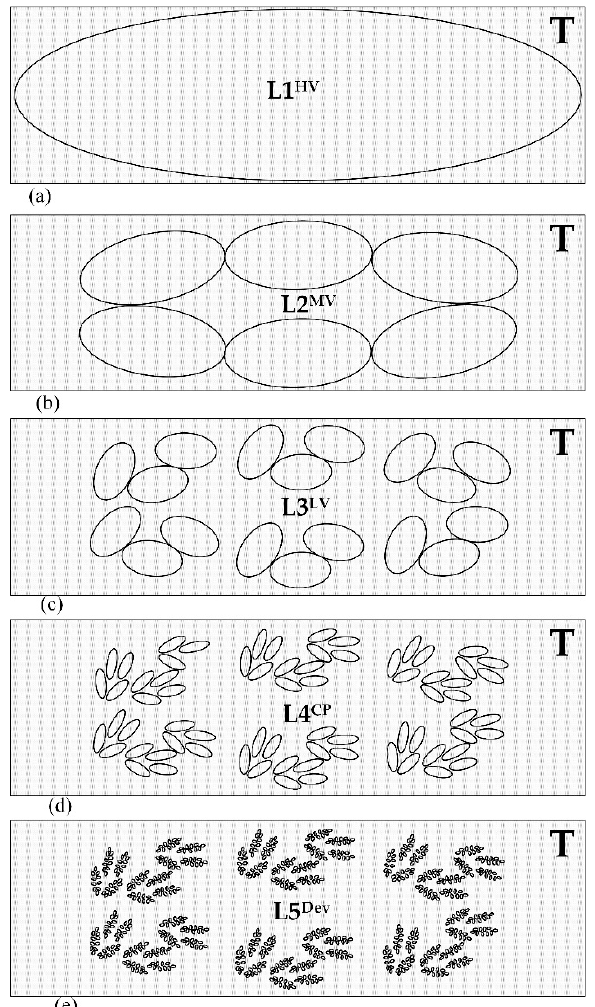
Figure 9. Smart grid’s separate fractal sets in different levels: ( a ) Level 1; ( b ) level 2; ( c ) level 3; ( d ) level 4; ( e ) level 5.